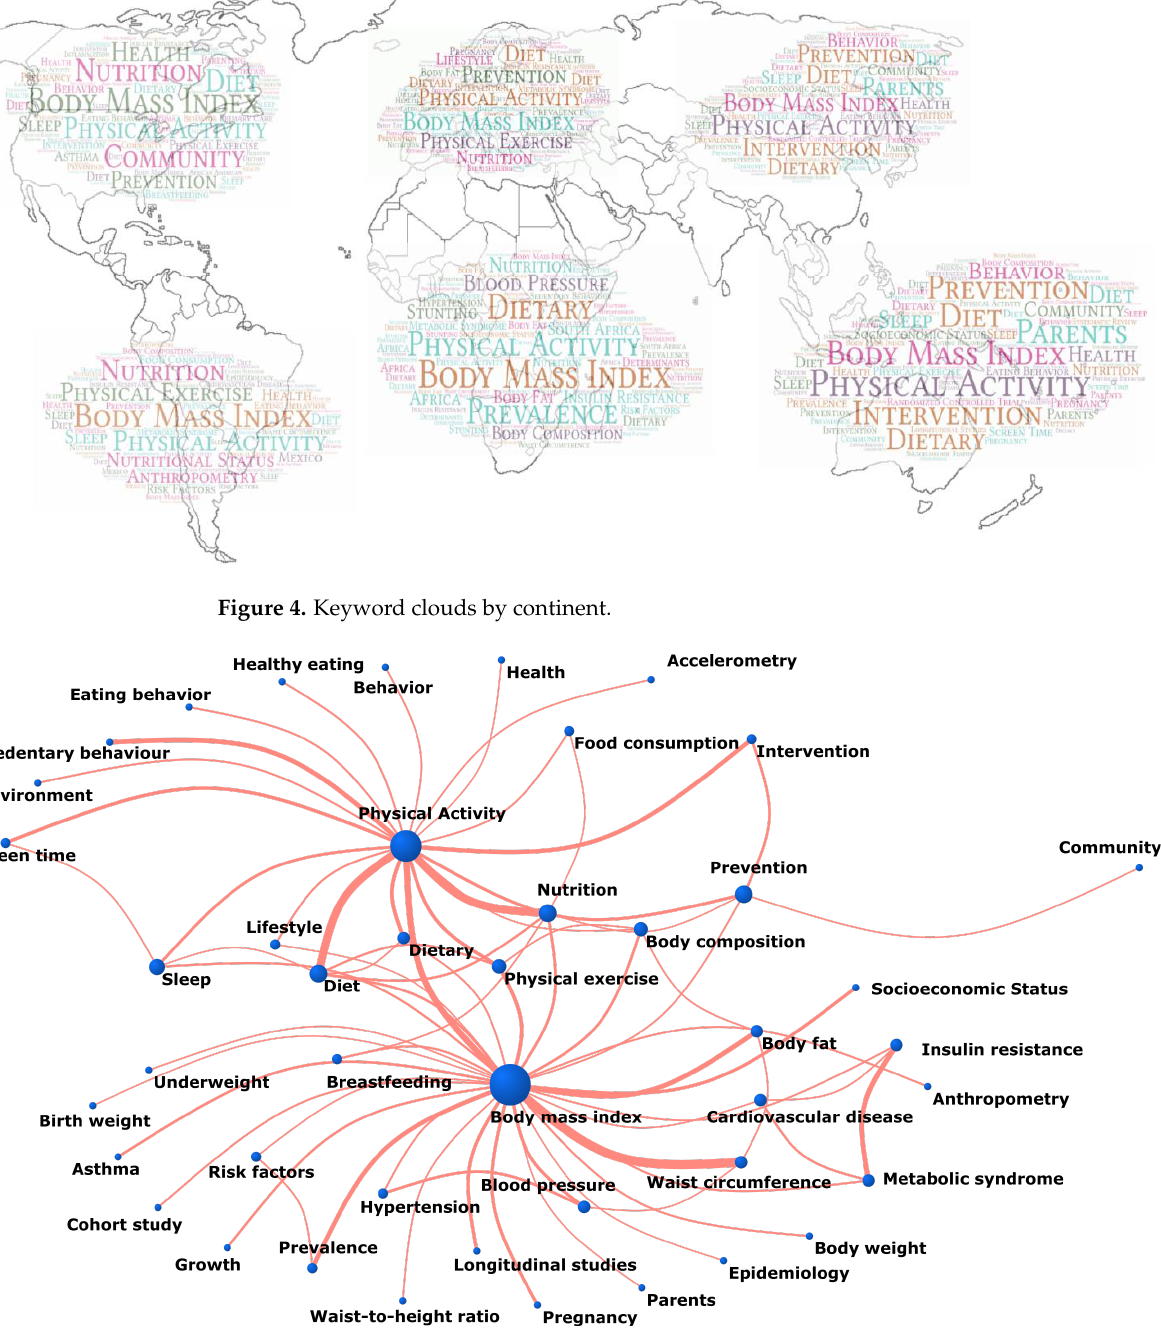
Figure 5. Network of co-words.